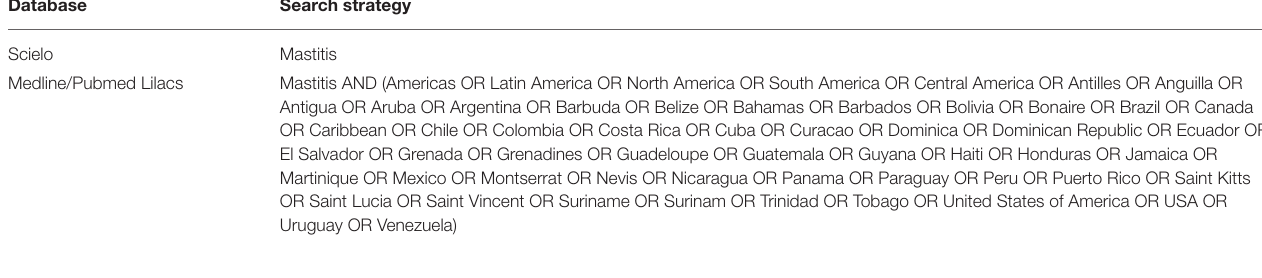
TABLE 1 | Search strategy of cases with non-lactational infectious mastitis in the Americas. Database